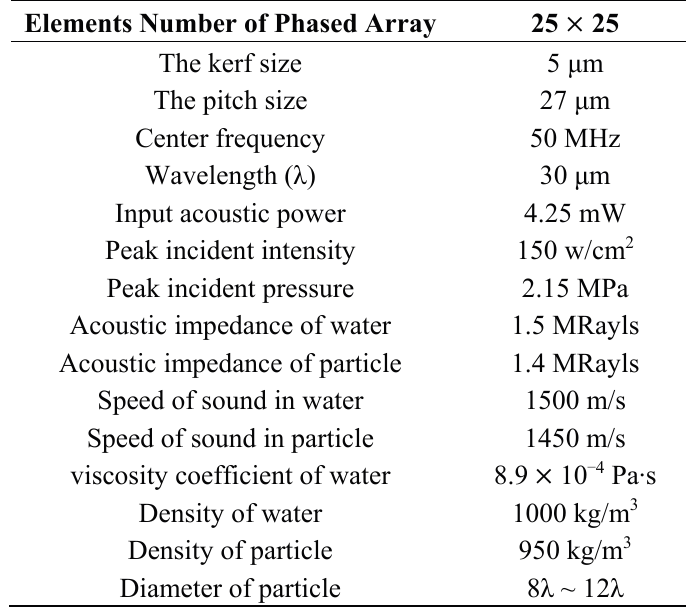
Table 1. Simulation